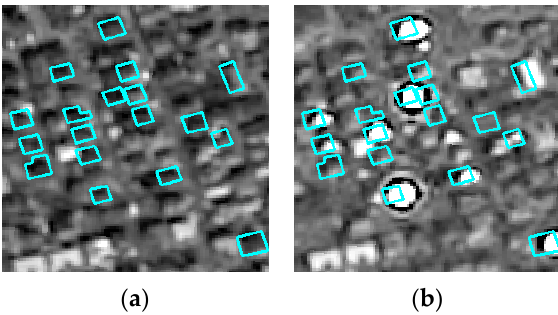
Figure 18. Examples of the wrong estimation of a FP due to anomalous bright pixels drawn in blue outline on a: ( a ) 20 March 2016 SPOT image; and ( b ) 25 March 2018 SPOT image.